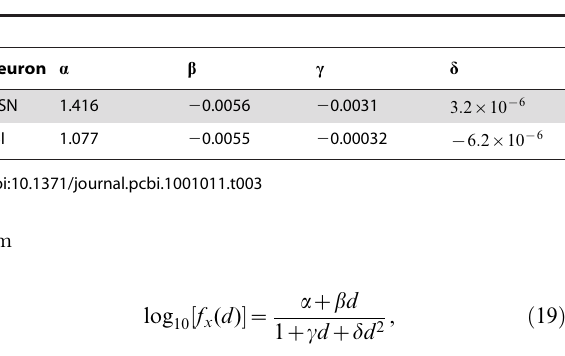
Table 3. Parameters for best-fit functions to the model predictions of total dendrite